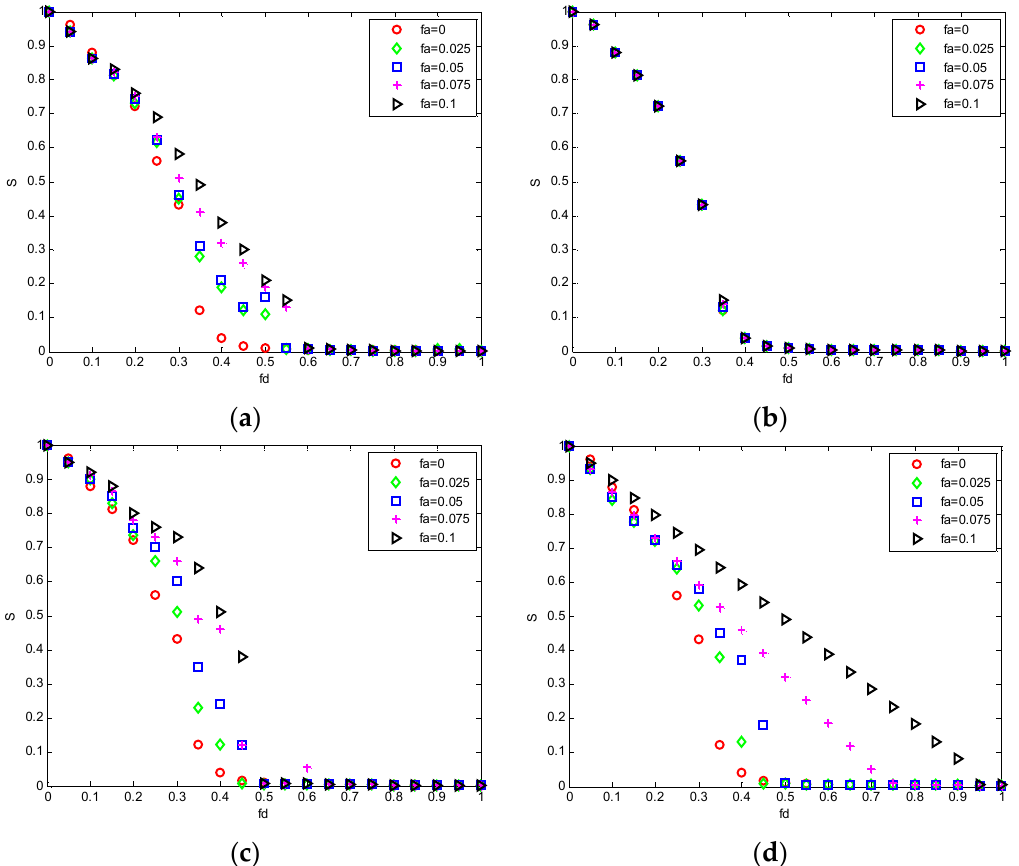
Figure 8. ( a ) RD edge-increasing strategy; ( b ) SMB edge-increasing strategy; ( c ) LBF edge-increasing strategy; and ( d ) LDF edge-increasing strategy.